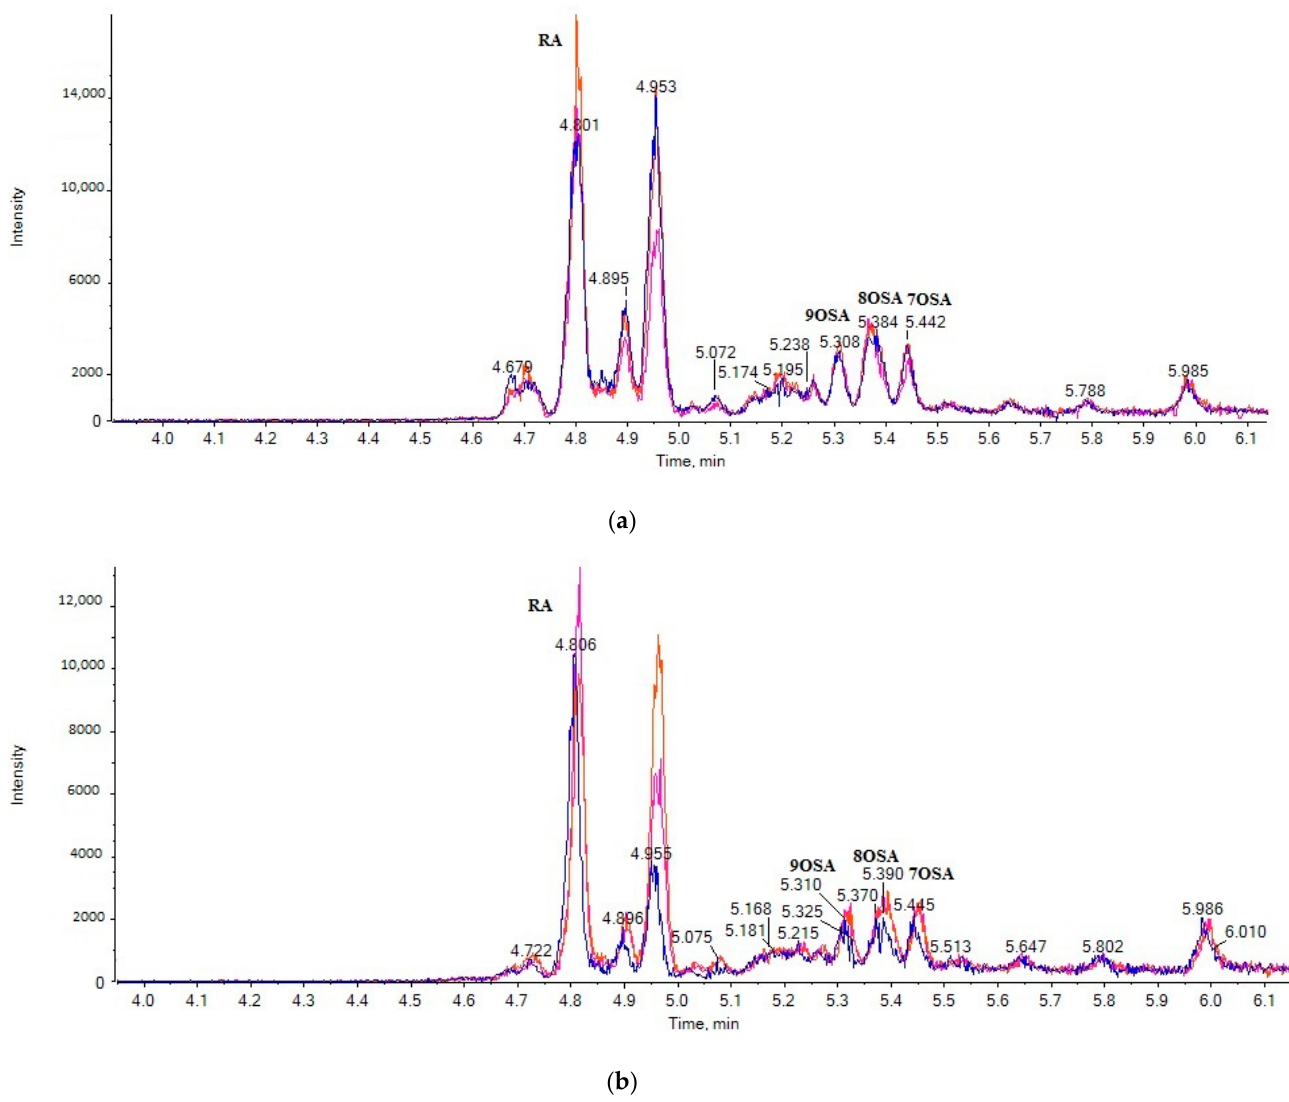
Figure 4. EICs of the multisample analysis for OSAs (exact mass m/z 297.2435) in three cow milk samples ( a ) and in three goat milk samples ( b ).